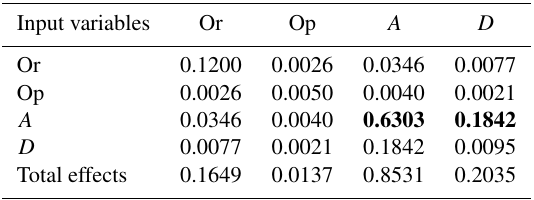
Table 2. Global sensitivity indices and total sensitivity indices. The values in bold font are the maximum main effect and second-order effect indices.